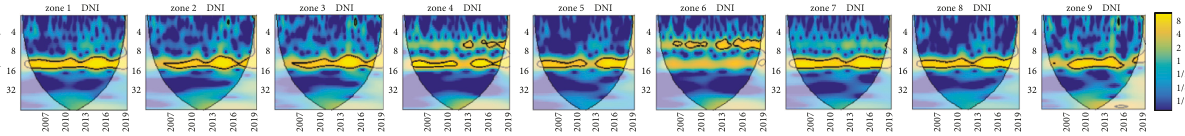
Figure 5: Continuous Morlet wavelet spectrum (CWS) of DNI over the 9 selected zones on a monthly scale during